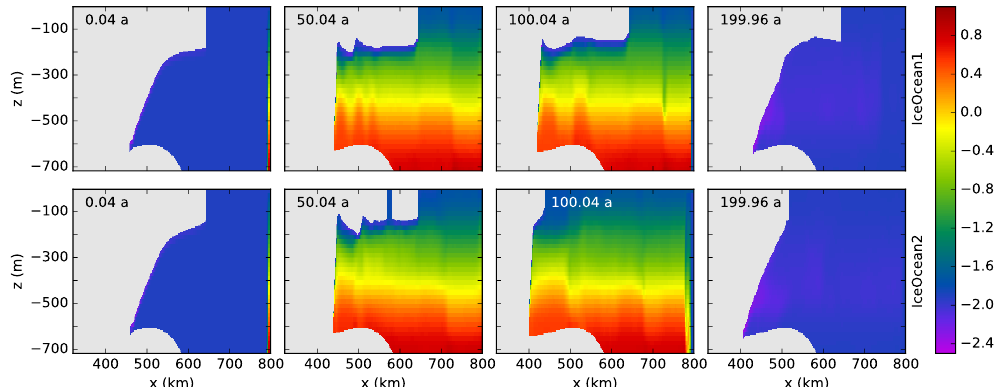
Figure 13. Example results from POPSICLES plotted as in Fig. 8 but for IceOcean1 (top) and IceOcean2 (bottom) simulations each lasting 200 years. Both simulations begin with ice shelves that are in steady state without melting and with COLD ocean conditions. The WARM far-field restoring in the ocean causes the melt rate to increase by several orders of magnitude over the first decade and for the ice shelf to thin over the remainder of the retreat phase (100 years). In IceOcean2, dynamic calving significantly reduces the size of the ice shelf compared with IceOcean1. During the final 100 years, the switch to COLD far-field restoring leads to cold ocean temperatures, melt rates are reduced by several orders of magnitude, and the ice shelf begins to re-advance; 100 years is not long enough for the ice shelf in either simulation to re-advance to its initial steady